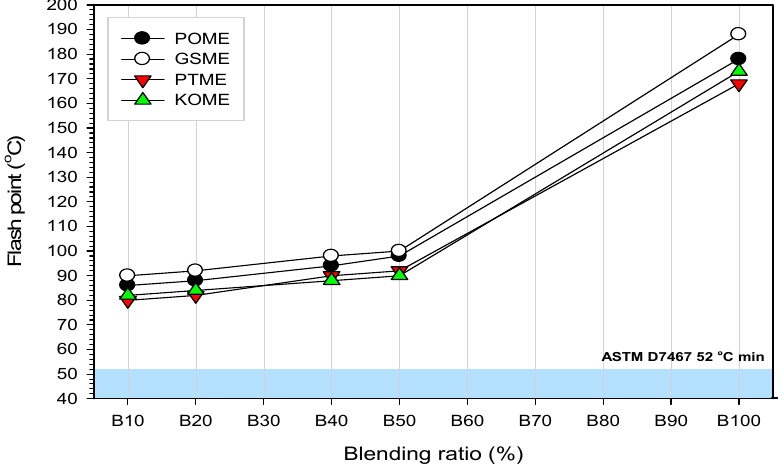
Figure 5. Effects of biodiesel–diesel blends on flashpoint. Figure 5. E ff ects of biodiesel–diesel blends on